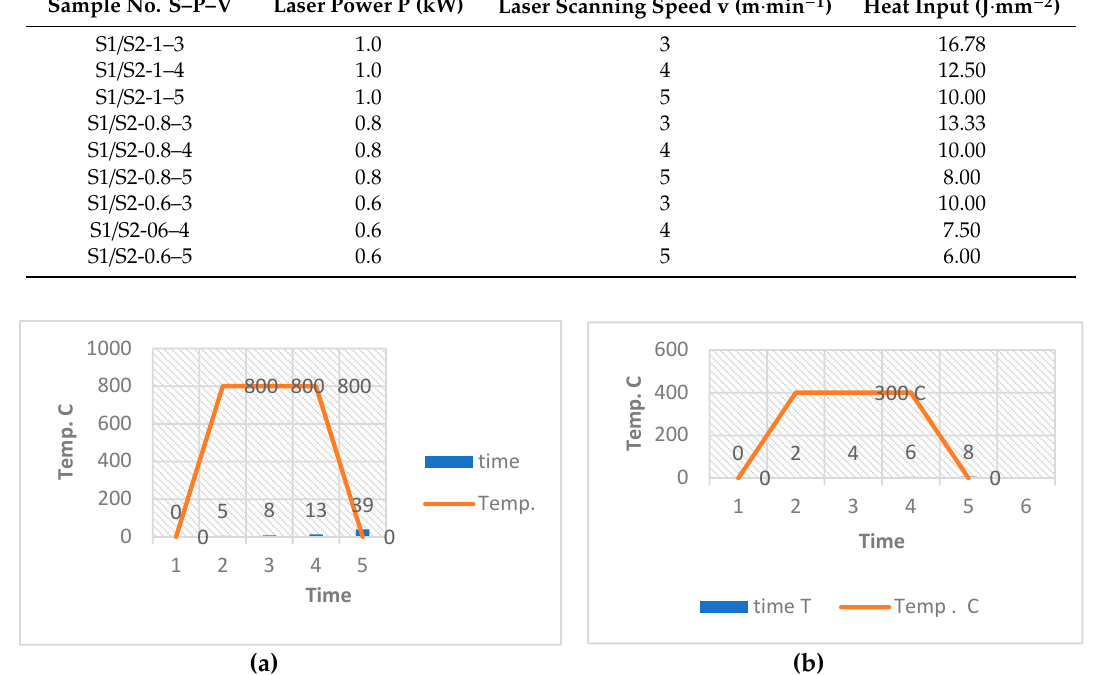
Figure 1. Conventional heat treatment process; ( a ) hardening heating and cooling cycles and ( b ) tempering heating and cooling cycles.